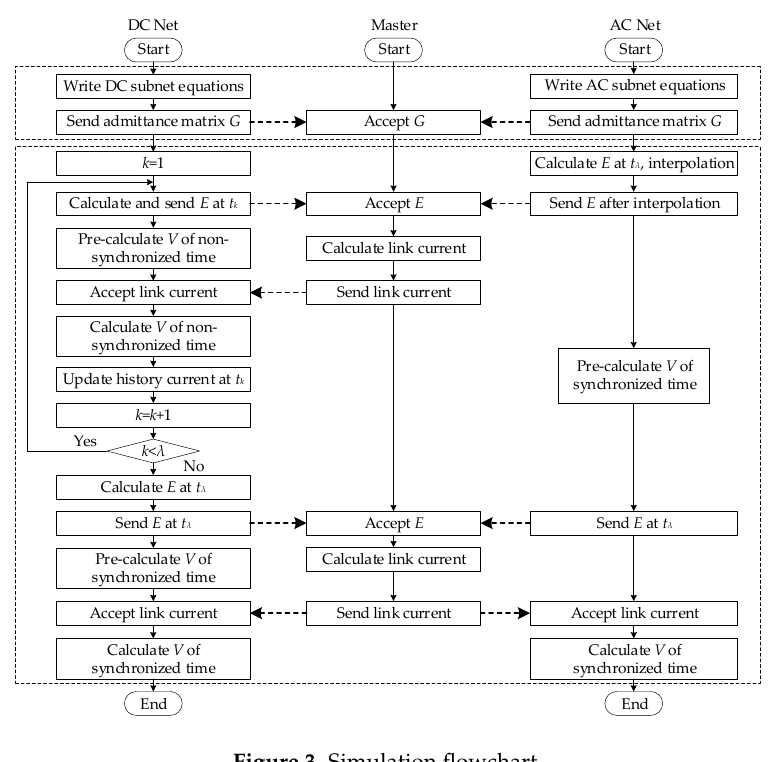
Figure 3. Simulation flowchart.